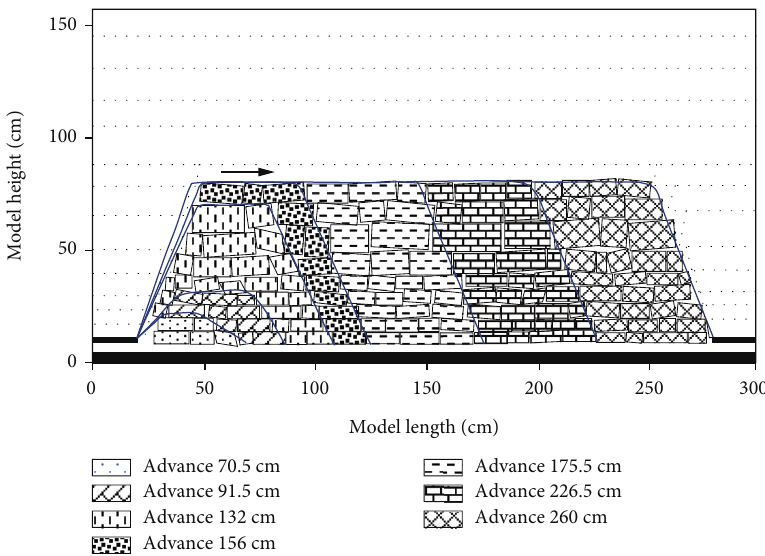
Figure 11: Evolution of overburden structure in the 3-2 coal seam.